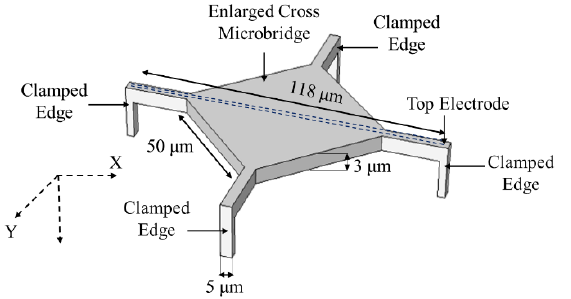
Figure 15. Schematic view of an enlarged cross microbridge structure (image not to scale).